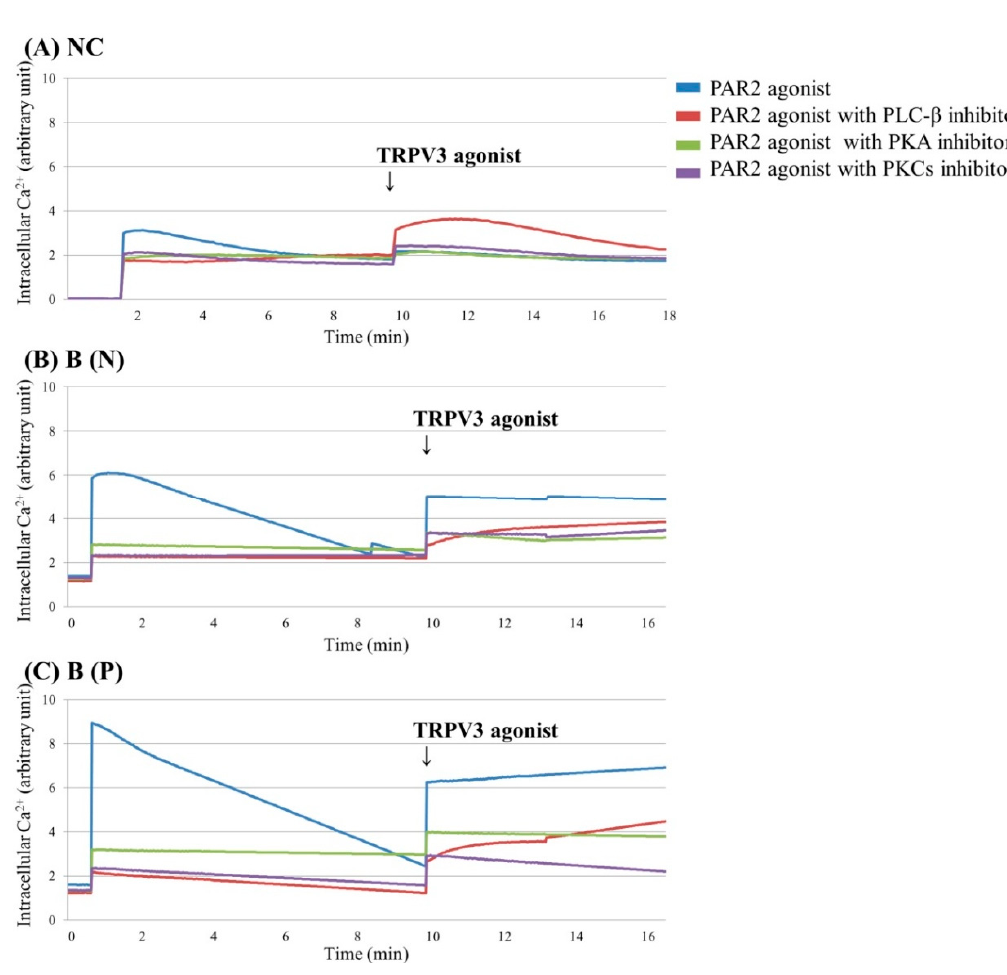
Figure 4. Ca 2+ influx in cultured keratinocytes of: ( A ) Normal control, ( B ) Nonpruritic burn scar and ( C ) Pruritic burn scar. Each group was pretreated with PAR2 agonist (100 μ M SLIGRL-NH2), PAR2 agonist with phospholipase C (PLC)- β inhibitor (10 μ M U73122), PAR2 agonist with protein kinase A (PKA) inhibitor (10 μ M H-89) or PAR2 agonist with and protein kinase C (PKCs) ( α , β , γ , δ , ε and ζ ) inhibitor (10 μ M GF109203X); then TRPV3 agonist (500 μ M Carvacrol and 200 μ M 2-APB mixture) was added. Inhibition of PKA and PKC, which are essential components of intracellular Ca 2+ influx signalling by PAR2, is associated with reduced intracellular Ca 2+ influx compared to the control, even when treated with PAR2 agonist or with additional TRPV3 agonist treatments. NC: keratinocytes from normal control; B (N): keratinocytes from a nonpruritic burn scar; B (P): keratinocytes from a pruritic burn scar.